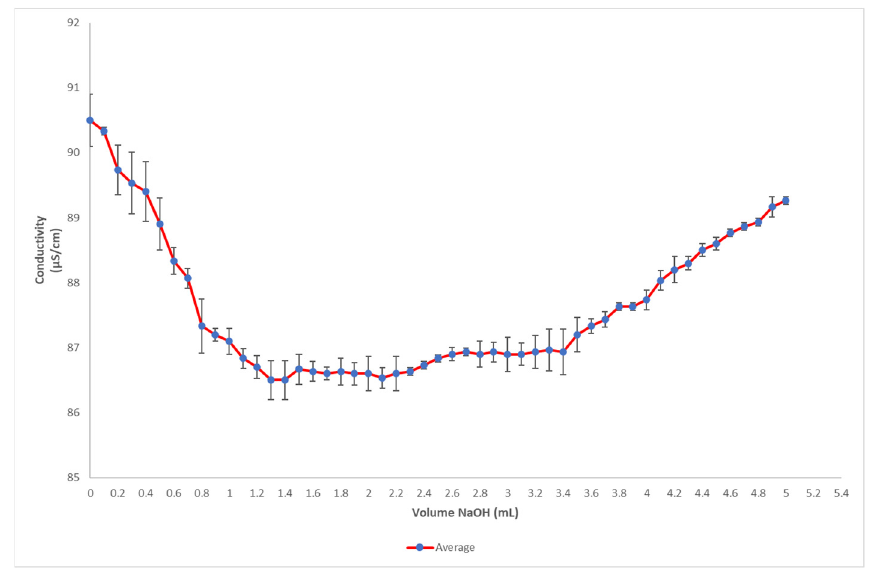
Figure 5. Titration curve of ivory nut nanocellulose from the endosperm of crude parenchyma treated with 8 M H 2 SO 4 for 4 h at 30 °C.